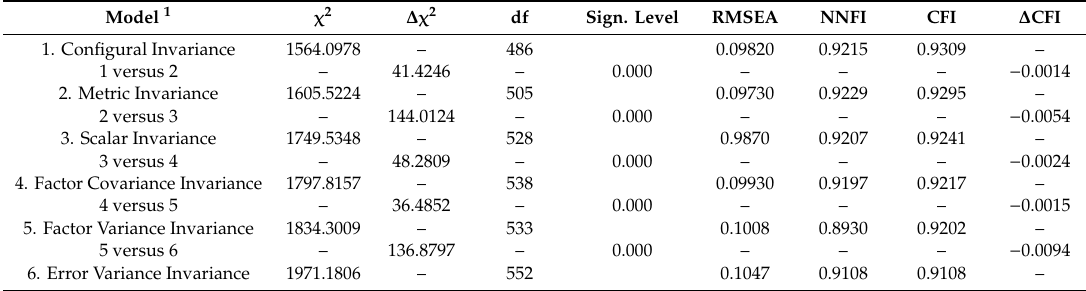
Table 5. Six steps of measurement invariance test between the two models.